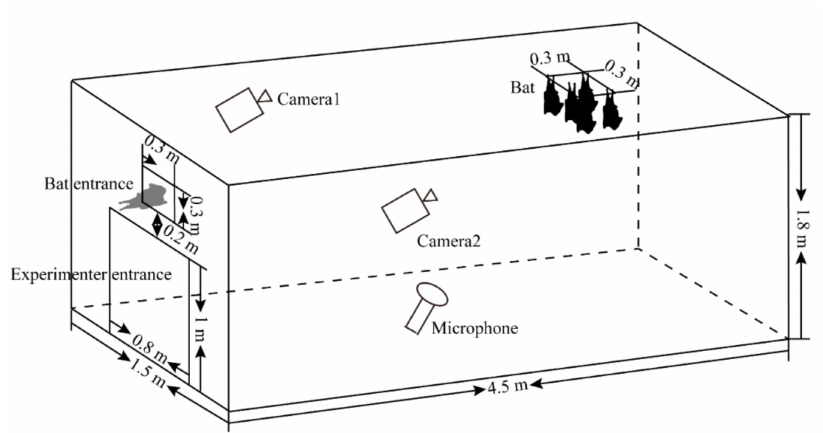
Figure 1. A schematic diagram of the territory defense experiment using sympatric species of Hipposideros armiger . The intrusive bat is shown in grey to distinguish it from roosting